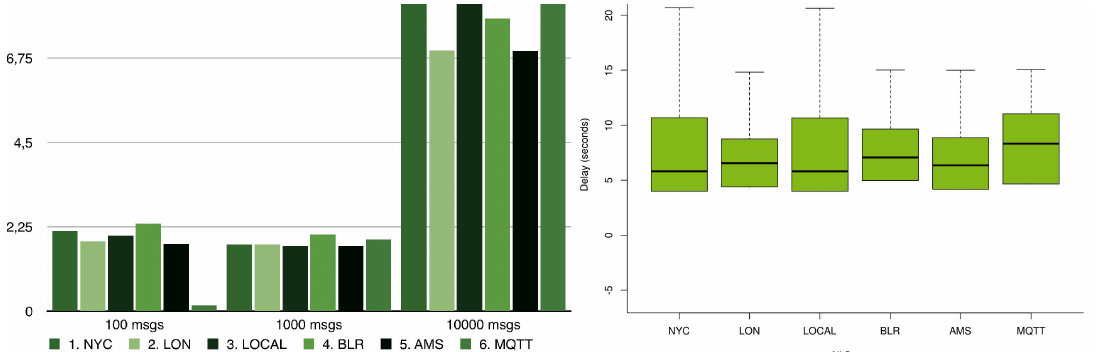
Fig. 5. Comparing message reception at various locations with MQTT, box plot with Maxi- mum delay over all trails.